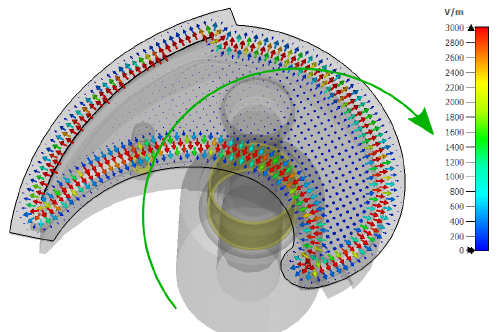
Figure 4. Electric field vector-plot of the fundamental TEM mode plotted along the cavity median plane; the green arrow represents the beam direction of motion. Note: arbitrary electric field normalization has been applied.